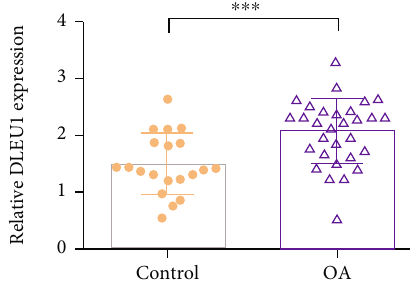
Control Figure 2: DLEU1 was overexpressed in OA specimens. The DLEU1 expression in the control cartilages and OA cartilages was detected by qRT-PCR assay. GAPDH was used as the internal control. ∗∗∗ p < 0 : 001